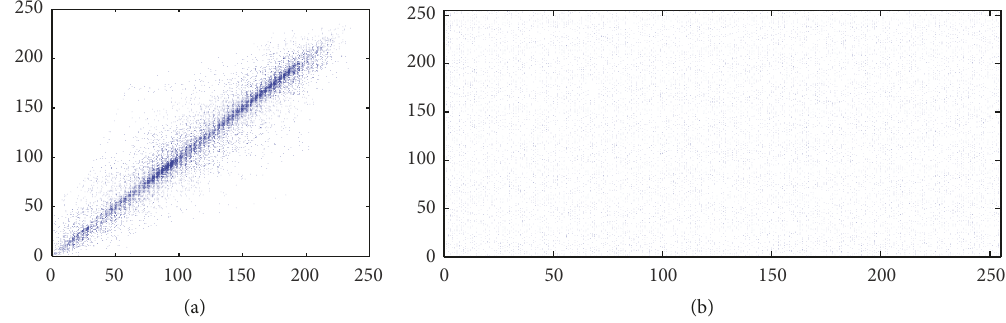
Figure 7: Correlation distributions of original and encrypted images.